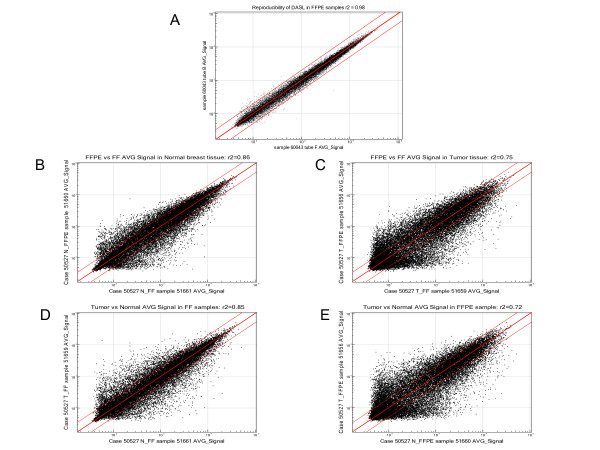
Scatter plot of the log2-transformed signal intensities. Scatter plot of the log2-transformed signal intensities of representative samples are shown in 1A - 1E. The central straight line represents the regression line and the two lines on the either sides mark the boundaries for 2-fold changes. Pearson correlation coefficient squared (r2) for each scatter plot is shown on the top. Figure-1A shows the signal intensities of two technical replicates of RNA samples. Figure-1B & 1C show correlations between corresponding FF (x-axis) & FFPE samples (y-axis) in normal breast tissue and tumor tissue respectively. Figure 1D & 1E show correlations between corresponding tumor (y-axis) and normal (x-axis) tissue from same patient using FF and FFPE samples respectively.